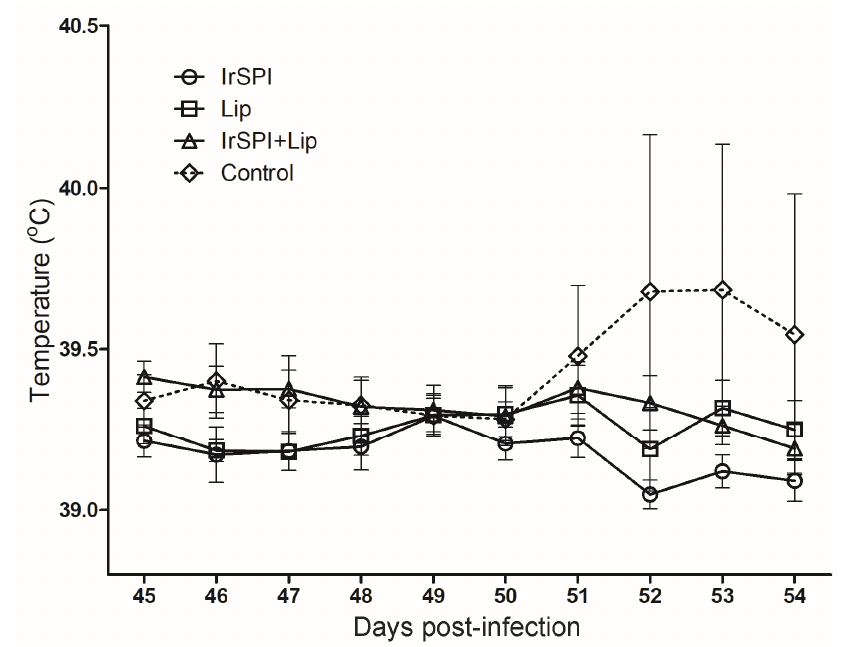
Figure 1. Daily temperature (°C) recorded for groups of sheep vaccinated with IrSPI ( I. ricinus serine protease inhibitor), IrLip1 ( I. ricinus lipocalin 1), IrSPI and IrLip1, and the control group injected with adjuvant from 45 to 54 days after immunisation. Animals were infested with An aplasma phagocytophilum- infected Ixodes ricinus nymphs on day 46. The dotted line representing the control group that received only adjuvant has a very large standard deviation due to a single sheep with a high fever of up to 42 °C on day 52. Results are presented as means ± standard deviation.